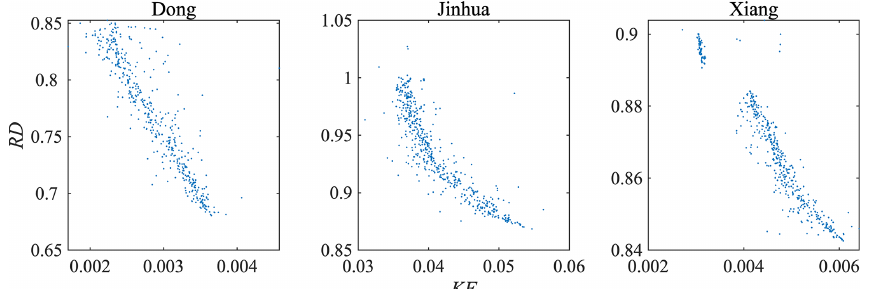
Figure 8. Relationship between KF and RD in the three cases.